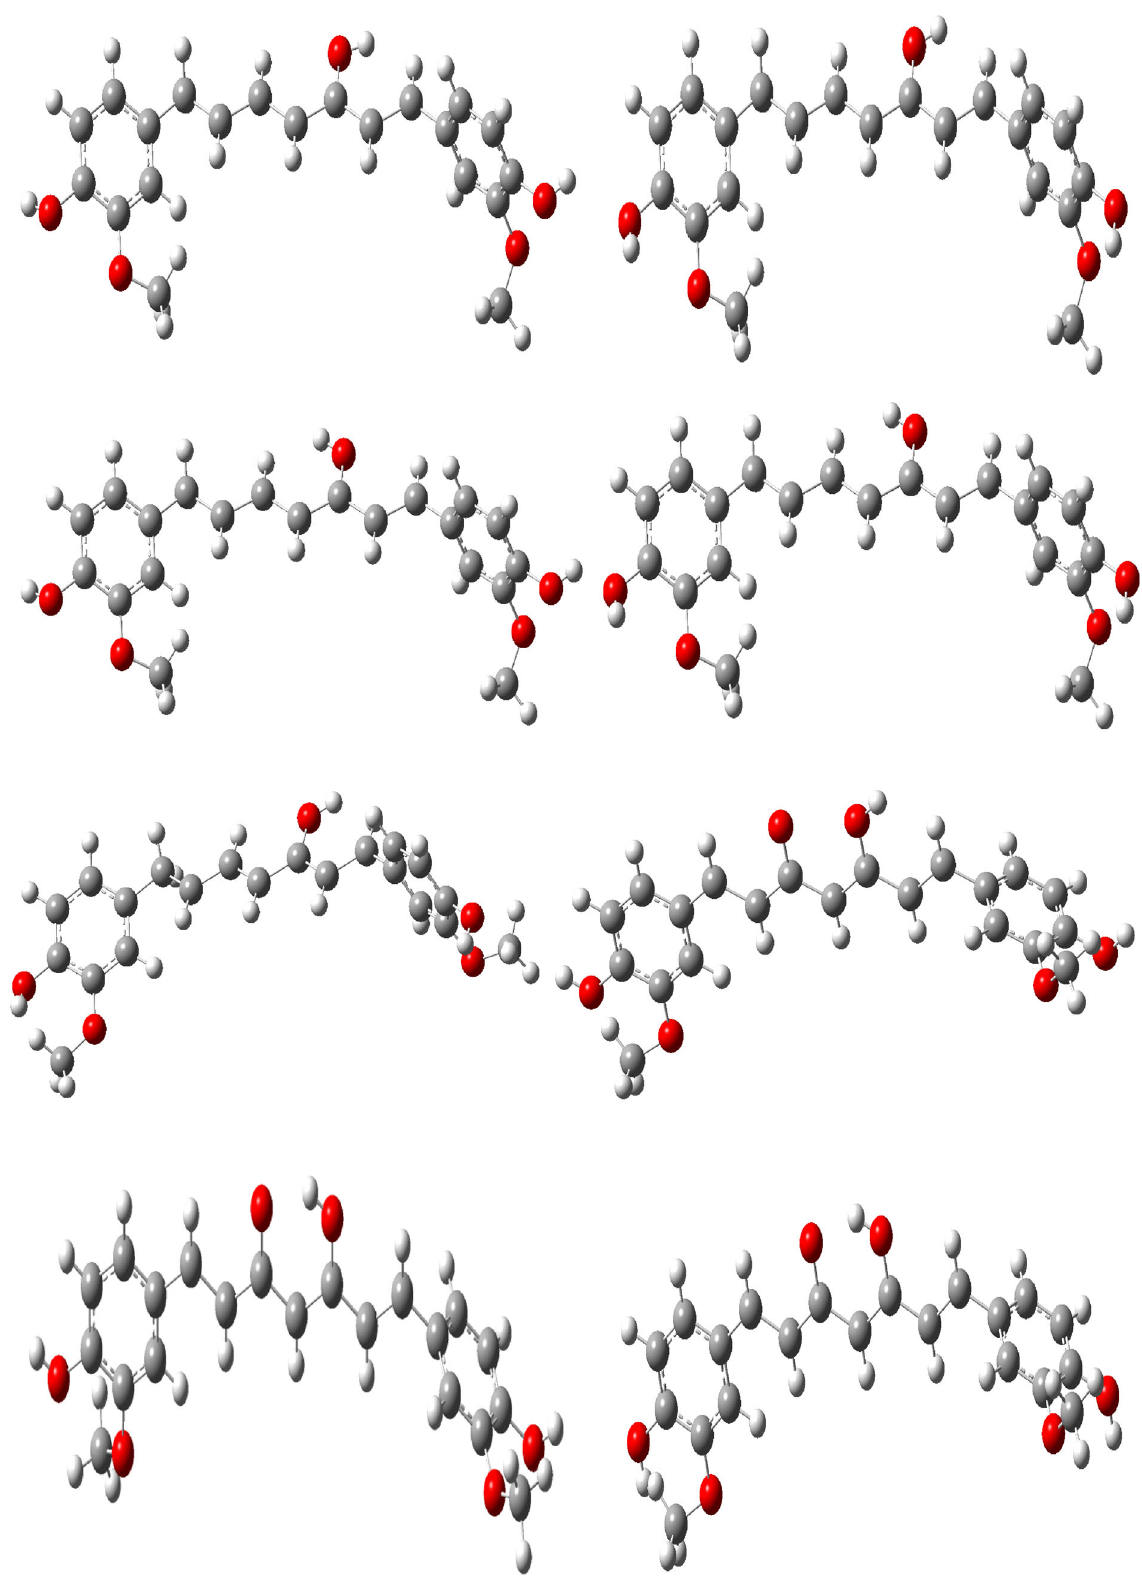
Fig. 3 Various conformers of